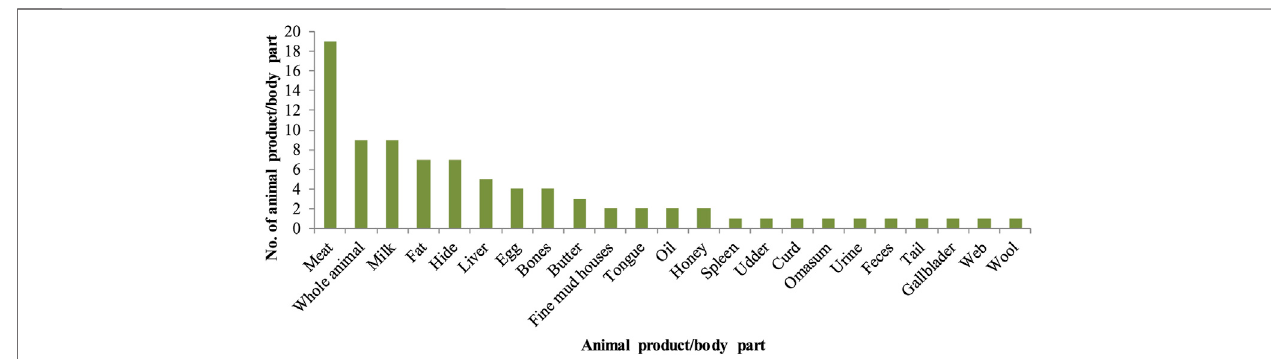
FIGURE 4 | Number of animal products or body parts used in ethnomedicine.